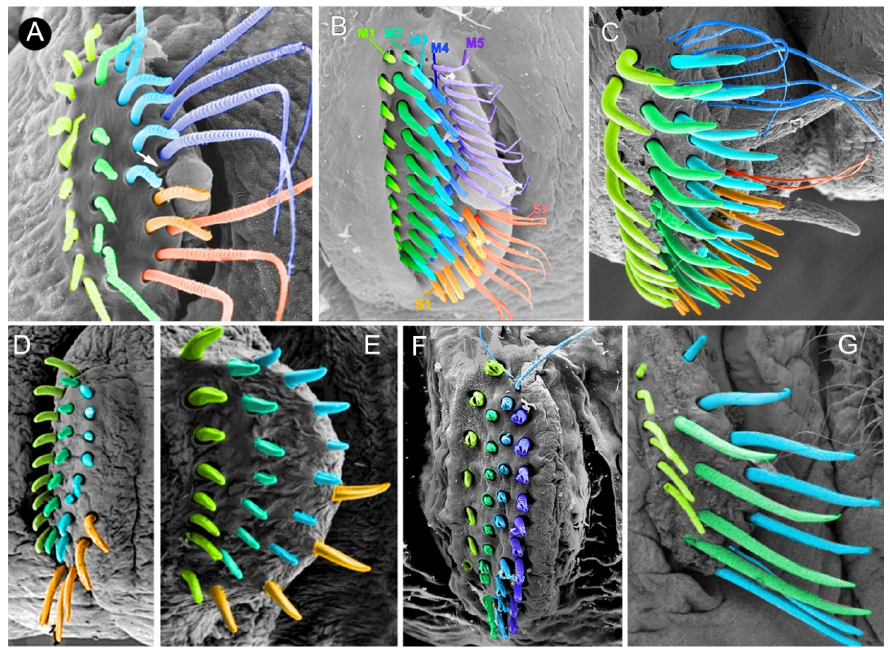
Figure 7. Thoracic neuropodia of Orbiniidae with colored rows of chaetae, SEM. ( A ). Scoloplos armiger , juvenile, Ch 1; ( B ). Scoloplos acutissimus , Ch 11; ( C ). Orbinia camposiensis , Ch 18; ( D ). Leodamas verax ; ( E ). Leodamas cirratus ; ( F ). Leodamas dubia , Ch 15; ( G ). Califia bilamellata , Ch 3. Rows designations are given according to Hoffmann and Hausen [111]: green, blue and purple colors indicate main rows (M1–M5), orange and red—secondary rows (S1, S2; white arrow points formative site). The anterior end is on the left in all photos. A : after Hoffmann and Hausen [111]; ( B , F ): after Zhadan et al. [102]; ( C ): after Le ã o and Santos [107]; ( D – G ): after Blake [74]. Photos are not in